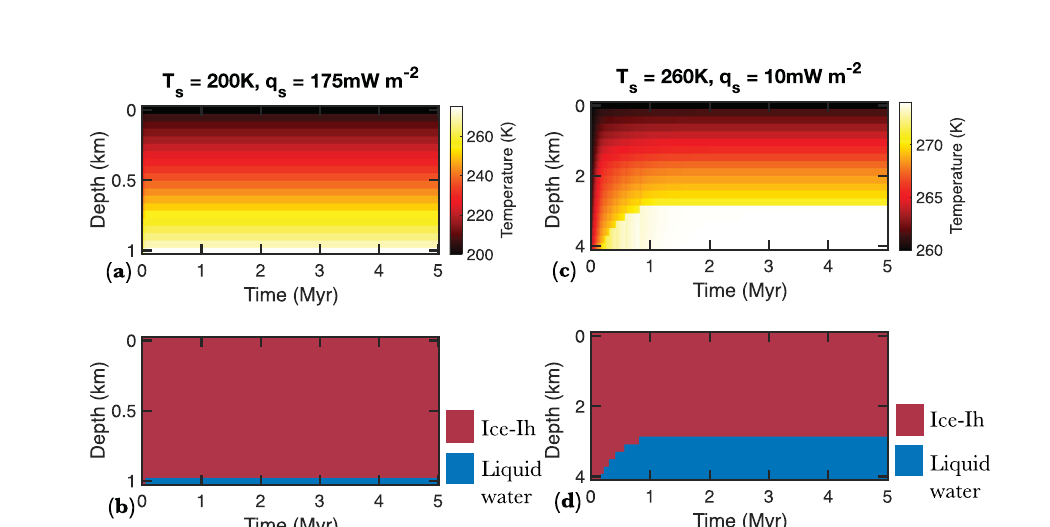
Fig. 5 | Temperature and ice phases as a function of depth within a thick ice sheetonTRAPPIST1gandKepler442b.a Temperaturedistributionasafunction of depth and time on TRAPPIST 1g for a 1km thick ice sheet, T s of 200K, and heat fl ow of 175mWm − 2 . b Ice phase evolution as a function of depth and time on